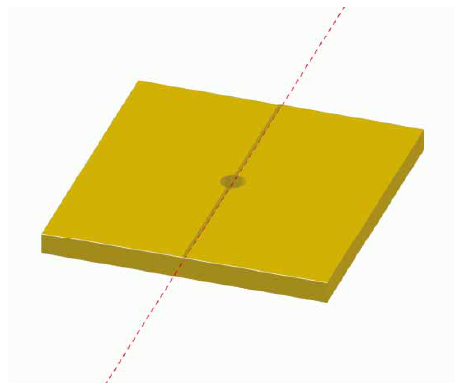
Fig. 2. Scheme of the permanent monumentation